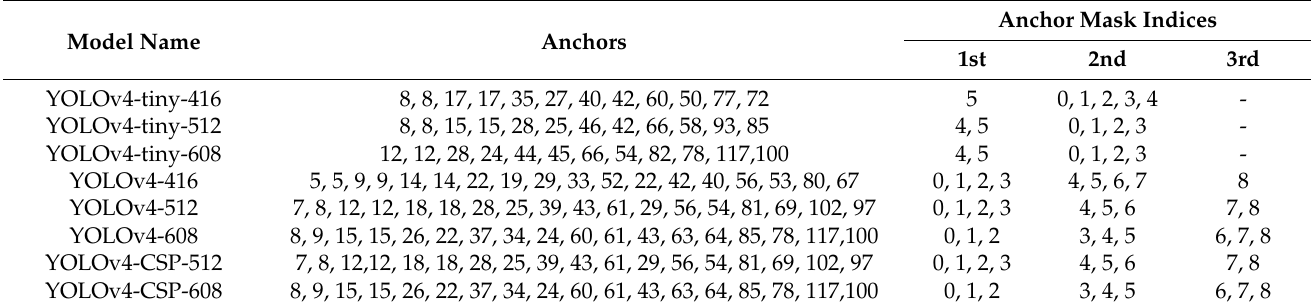
Table A1. Anchors of the YOLOv4 models.